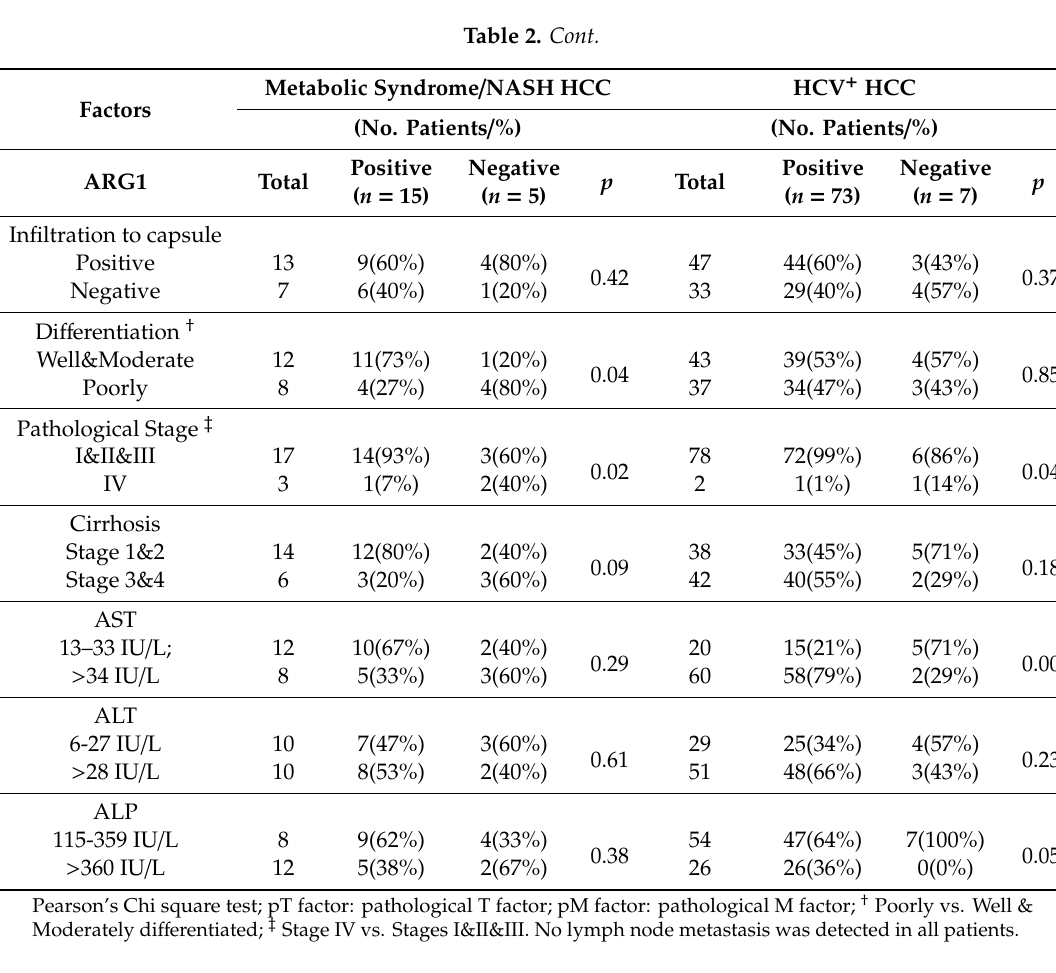
Table 2. Correlation between ARG1 expression and clinicopathological variables.